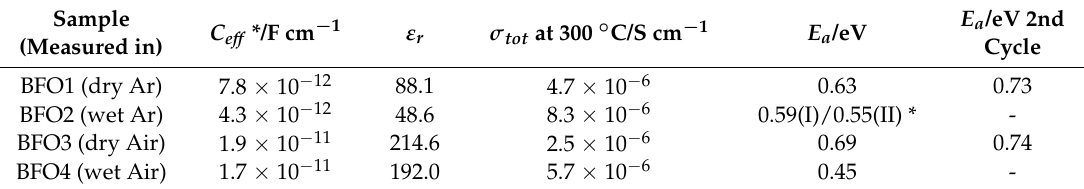
Table 5. Electrochemical parameters extracted from EIS data. Effective capacitance (C eff ), relative permittivity ( ε r ), conductivity at 300 °C ( σ ) , activation energy (E a ). Sample (Measured in)